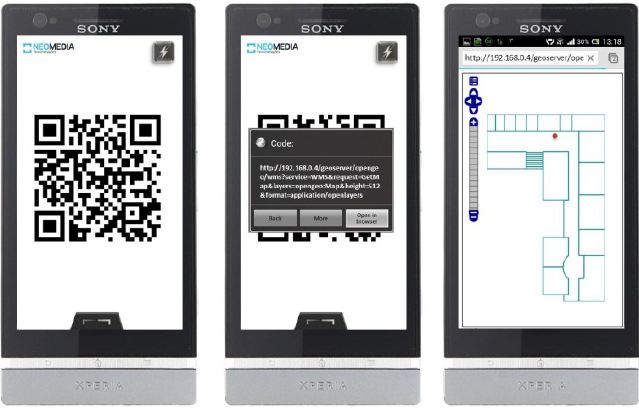
Figure 4. The map presented each marker’s position as a red dot Second types of barcodes (i.e. identifier barcodes) are used for implementation of an Object Hyperlink system. Object hyperlinking is a new term that extends the current Internet to the real world